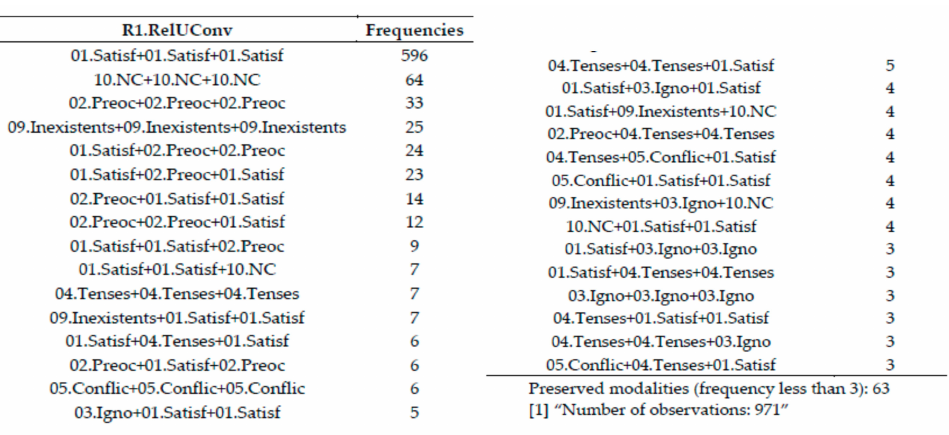
Figure 32. Trajectory frequency table for question R1: Rel UConv.